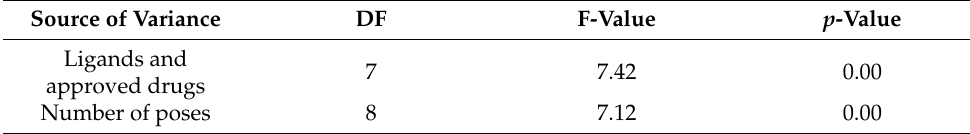
Table 1. One-way ANOVA for the binding affinities of the 9 poses (pose 0 to pose 8).